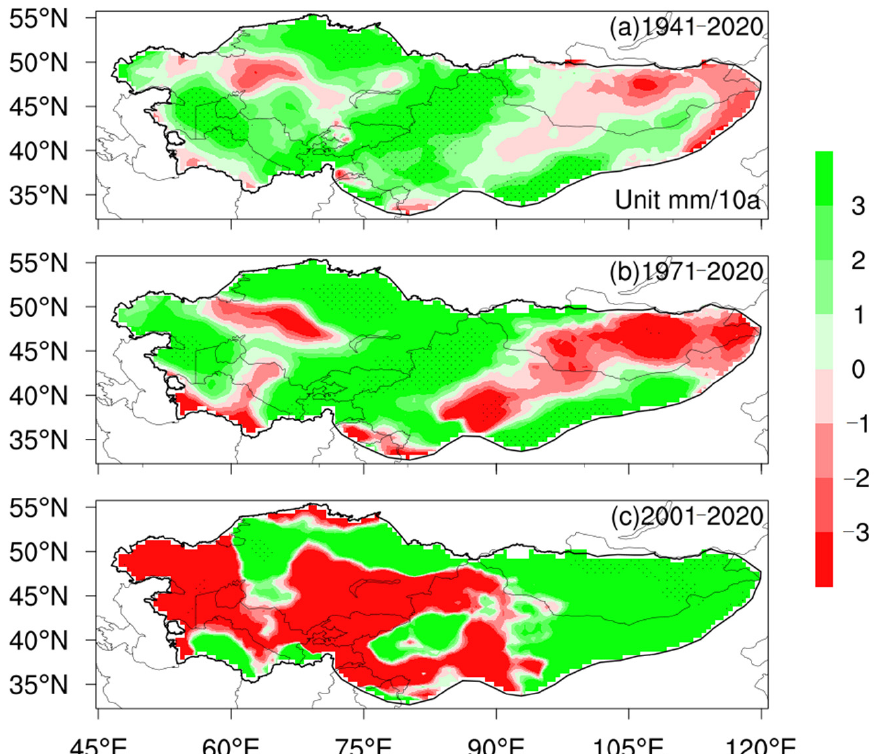
Figure 7. Variation rates (unit: mm/10a) of precipitation in the Pan-Central-Asia arid region during 1941–2020 ( a ), 1971–2020 ( b ), and 2001–2020 ( c ). The shaded region indicates where the variability has passed the significance test at 0.05 significance level—the same applies below.